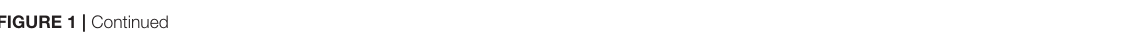
Frontiers in Cellular and Infection Microbiology |